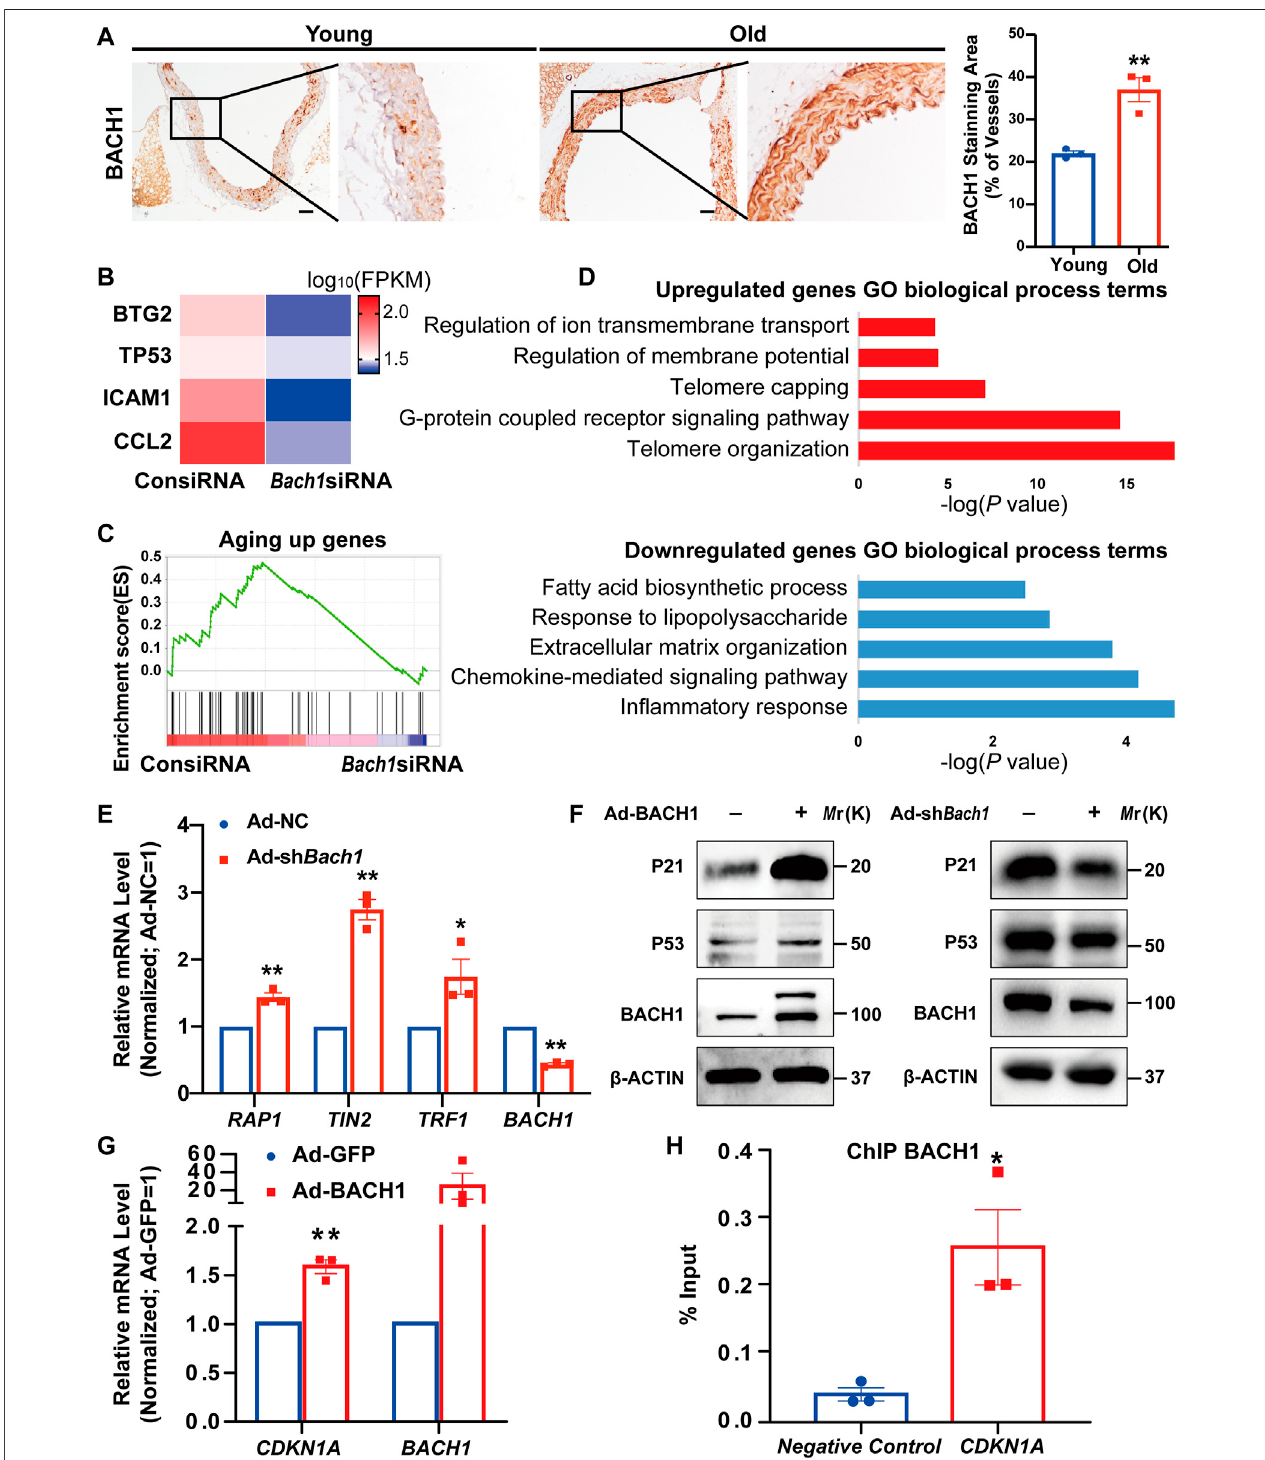
FIGURE 4 | BACH1 is upregulated in the aorta of old mice, and binds to the CDKN1A gene enhancer and activates its transcription. (A) Representative images of immunohistochemicalanalysisforBACH1stainingintheaortaofyoungmiceandoldmice( n (cid:2) 3pergroup).Scalebar,50 μ m.( n (cid:2) 3independentexperiments, dataare mean ± SEM, unpaired 2-tailed t -test, * p < 0.05, ** p < 0.01). (B) Heatmap illustrating RNA expression of selected genes related to aging in human umbilical vein endothelial cells (HUVECs) transfected with ConsiRNA or Bach1 siRNA. (C) Gene set enrichment analysis (GSEA) showing genes repressed by BACH1 deletion were associated with aging. (D) The Gene Ontology analysis of the signi fi cantly downregulated or upregulated genes in BACH1 silencing HUVECs compared with the